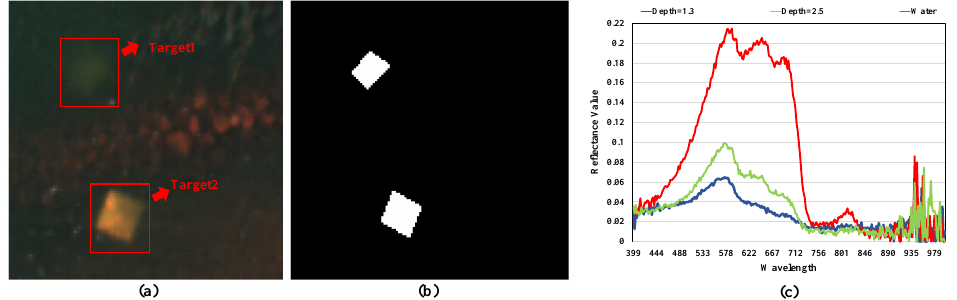
Figure 4. Real data set for experiment. ( a ) Image scene of turbid water; ( b ) distribution of desired targets; ( c ) spectra of desired targets and main backgrounds.